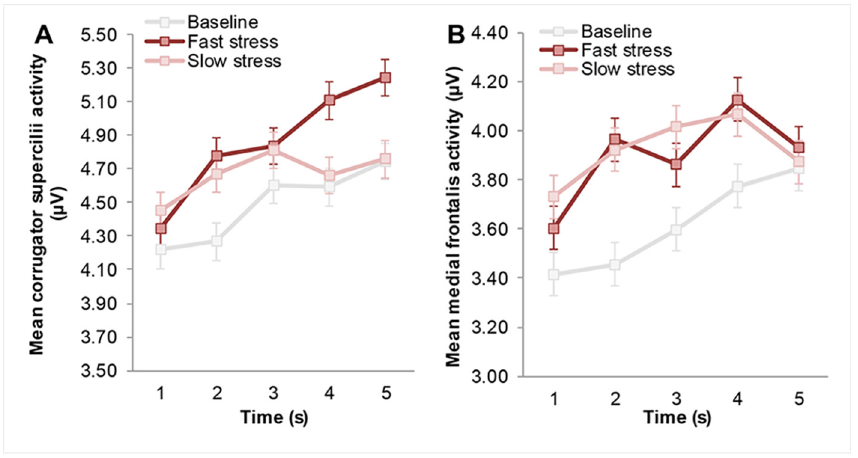
Fig 3. Mean facial muscle activity of receivers over time as a function of odor. (A) Mean corrugator supercilii activity (i.e., brow knit) following odor onset (in seconds). (B) Mean medial frontalis activity (i.e., brow lift) following odor onset (in seconds). Facial muscle activity displayed here was measured before the start of the facial expression classification task, to isolate the effect of odor. Error bars reflect 68% within- subjects CI of the interaction between odor and time.